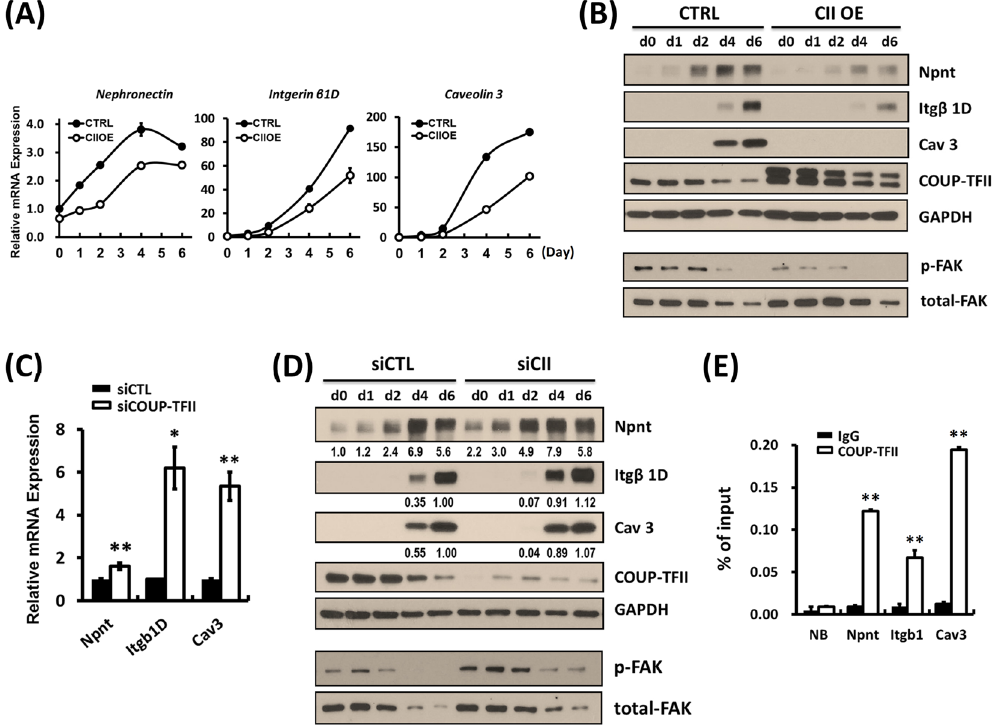
Figure 5. COUP-TFII represses FAK activity and directly regulates expression of moyblast fusion-associated genes in C2C12 cells. Quantitative RT-PCR examination of Nephronectin, Integrin β 1D and Caveolin 3 expression in ( A ) Ectopic COUP-TFII overexpressing cells post-serum withdrawal at the indicated time points; and ( C ) COUP-TFII silencing C2C12 cells one day after serum withdrawal. Total RNA was extracted using TRIzol ® reagent and mRNA expression levels were quantified by SyBr Green based RT-qPCR analysis. Western blot examination of indicated protein expression patterns in ( B ) ectopic COUP-TFII overexpressing and ( D ) COUP-TFII silencing C2C12 cells during myogenesis. The cells were harvested with 0.1% SDS-RIPA lysis buffer at the indicated time points under serum withdrawal culture condition. Equal amounts of cell lysates were subjected to immunoblotting with the indicated antibodies. Protein expression levels were quantified by densitometry, normalized by GAPDH levels, and shown in the bottom panel as relative values. ( E ) ChIP- qPCR analysis of the recruitment of COUP-TFII to the Npnt, Itgb1 and Cav3 enhancer region. Bar graph showed the enrichment of DNA fragments pulled down by COUP-TFII antibody. NB: non-binding region. Data are shown as mean ± SEM. Two-tailed Student’s t test; * p < 0.05, ** p < 0.01, compared to IgG